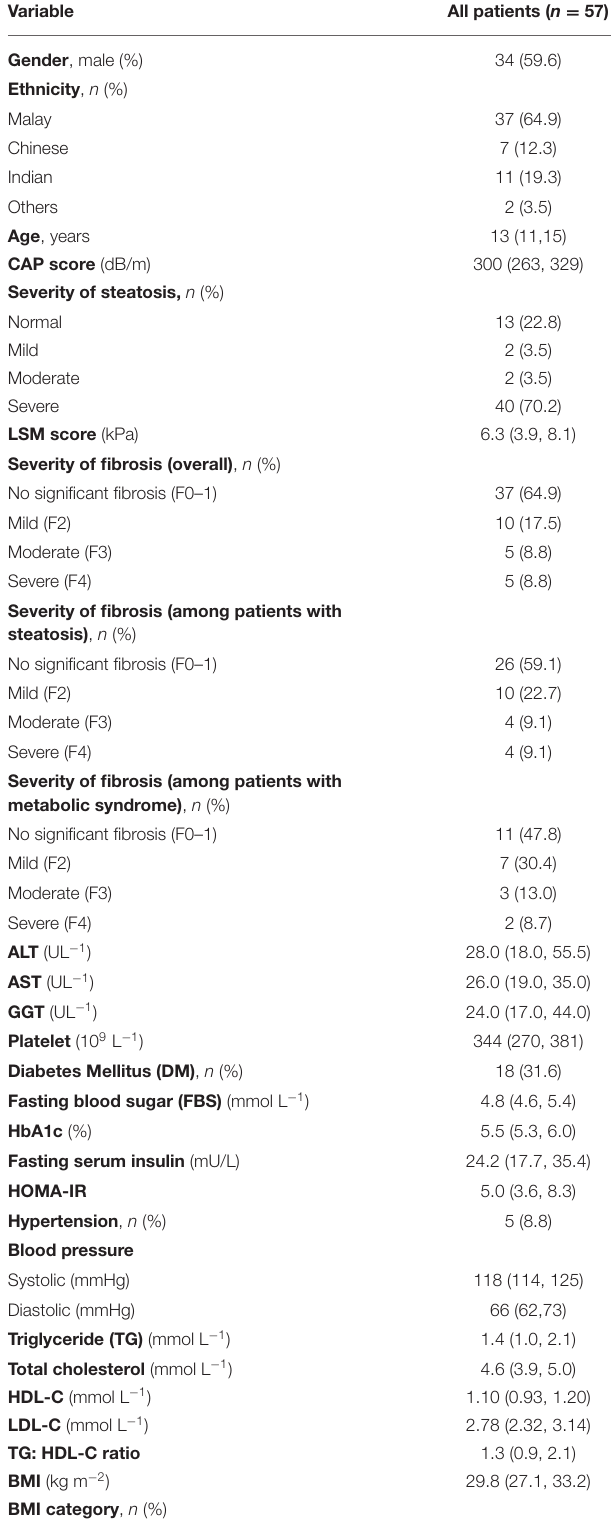
TABLE 1 | Demographic and clinical characteristics of overweight and obese children ( n =